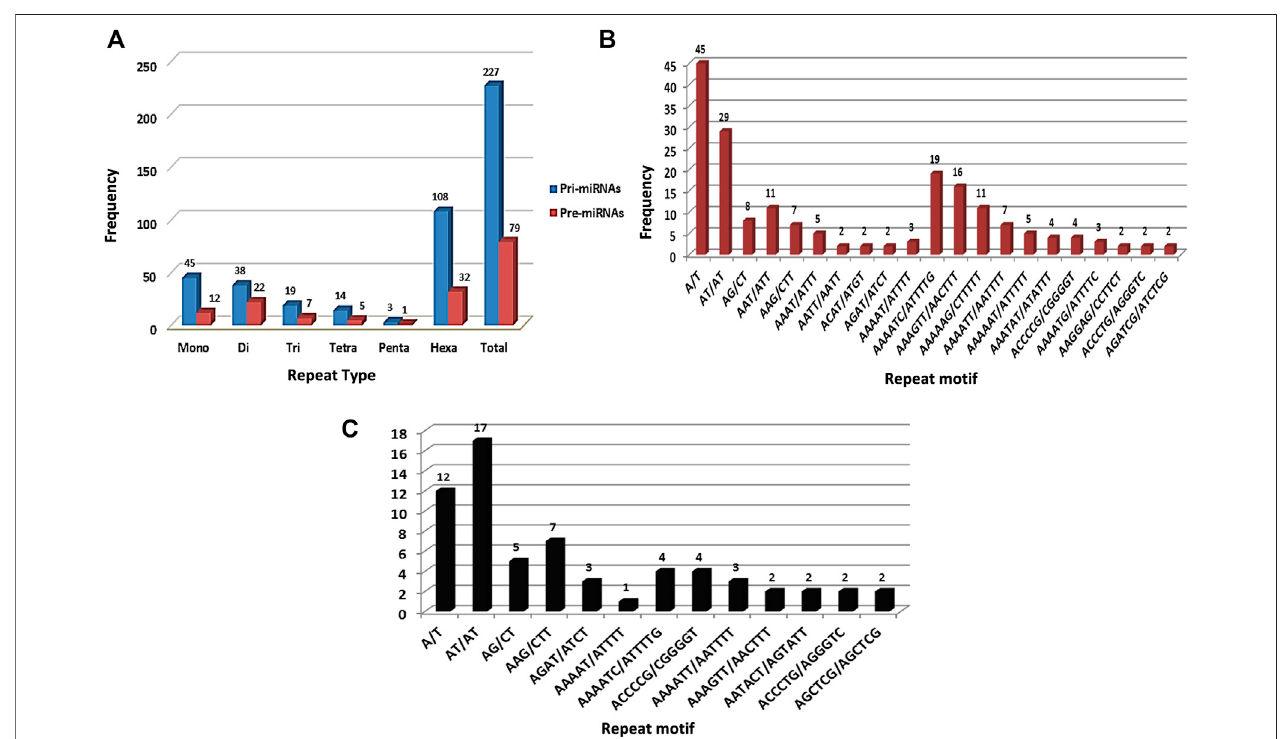
FIGURE 1 | Frequency distribution for SSR repeats in pri- and pre-miRNA sequences of pomegranate genome cv. Dabenzi.